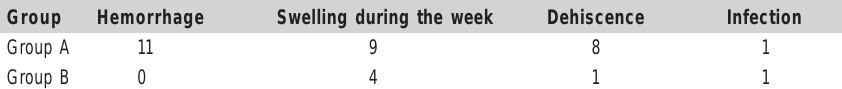
Table 2- The frequency of wound complications after dental extraction in the groups of the study.